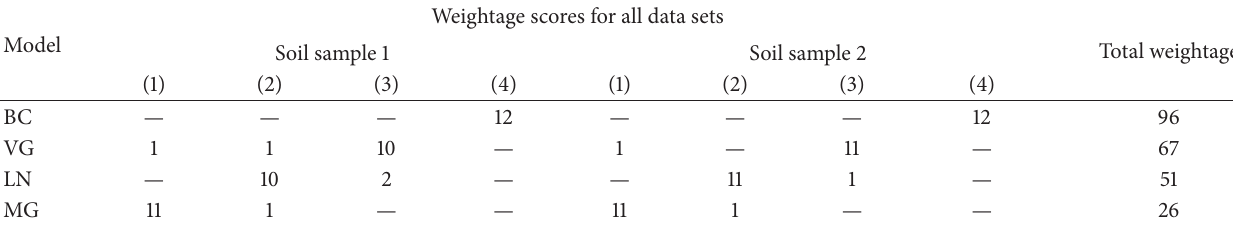
Table 5: Summary of weightage evaluation results for all data